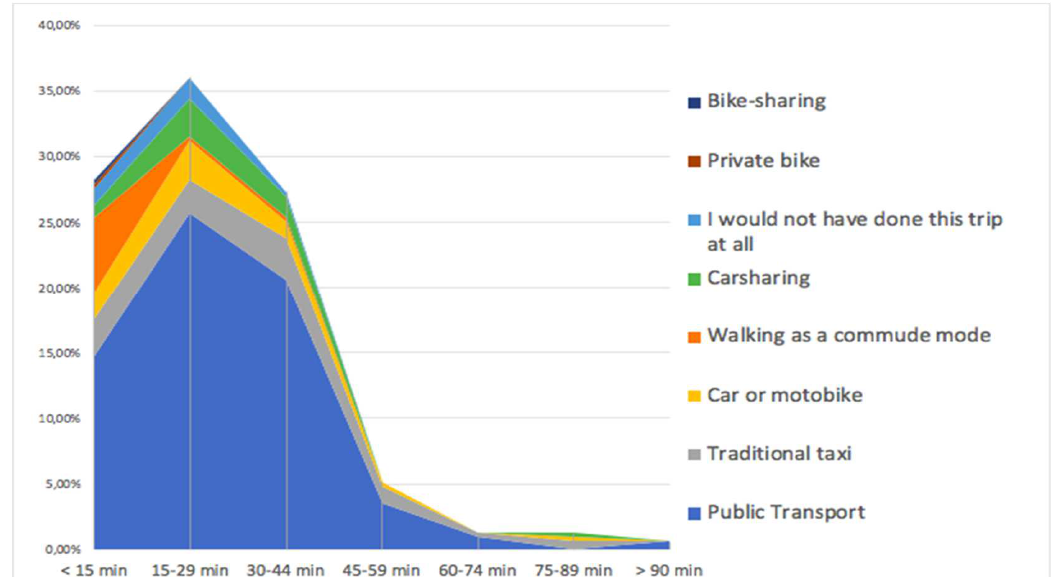
Figure 6. The last TNC trip: frequency of duration and alternative modes (N = 311, % of all TNC users).